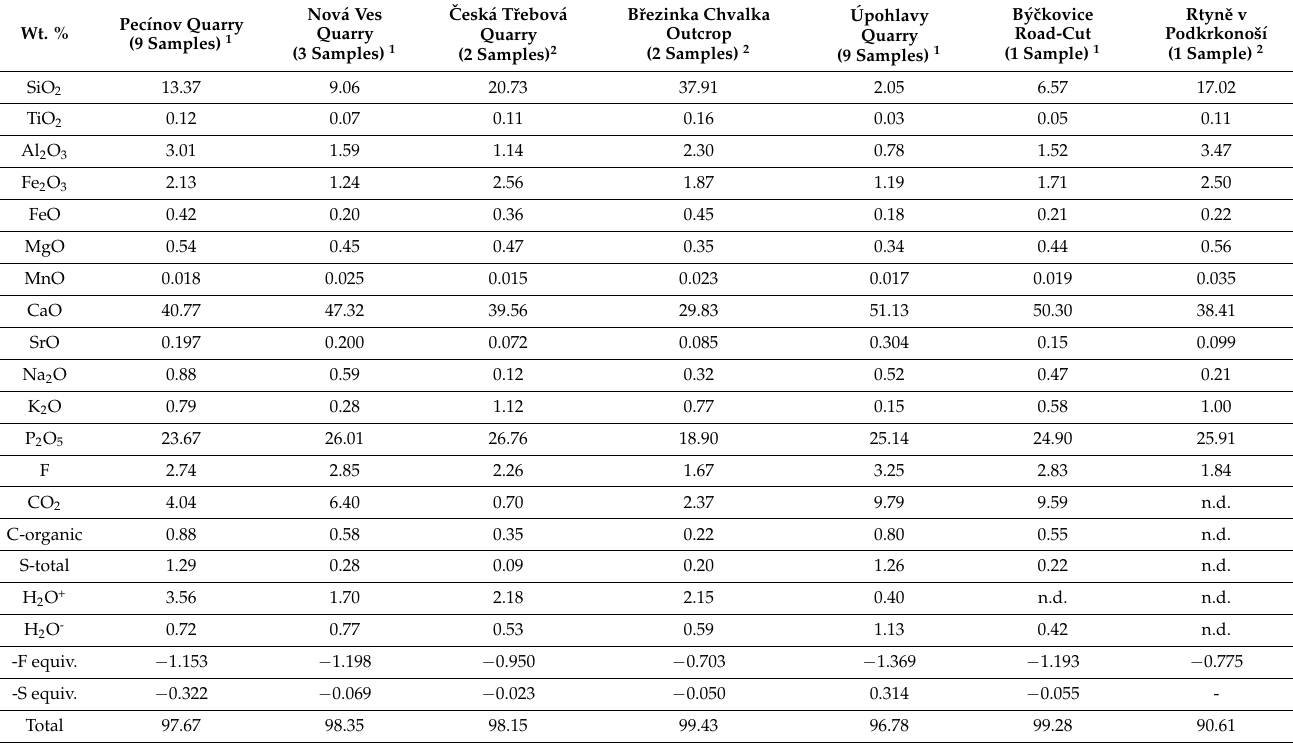
Table 3. Average major elements’ chemical composition of the Turonian